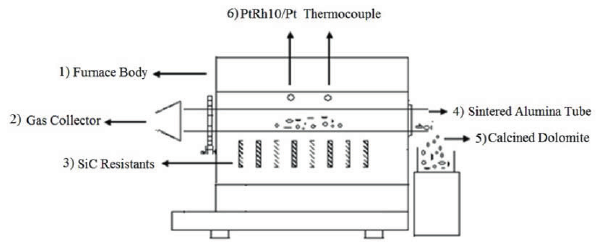
Figure 1. Rotary furnace used for calcination.